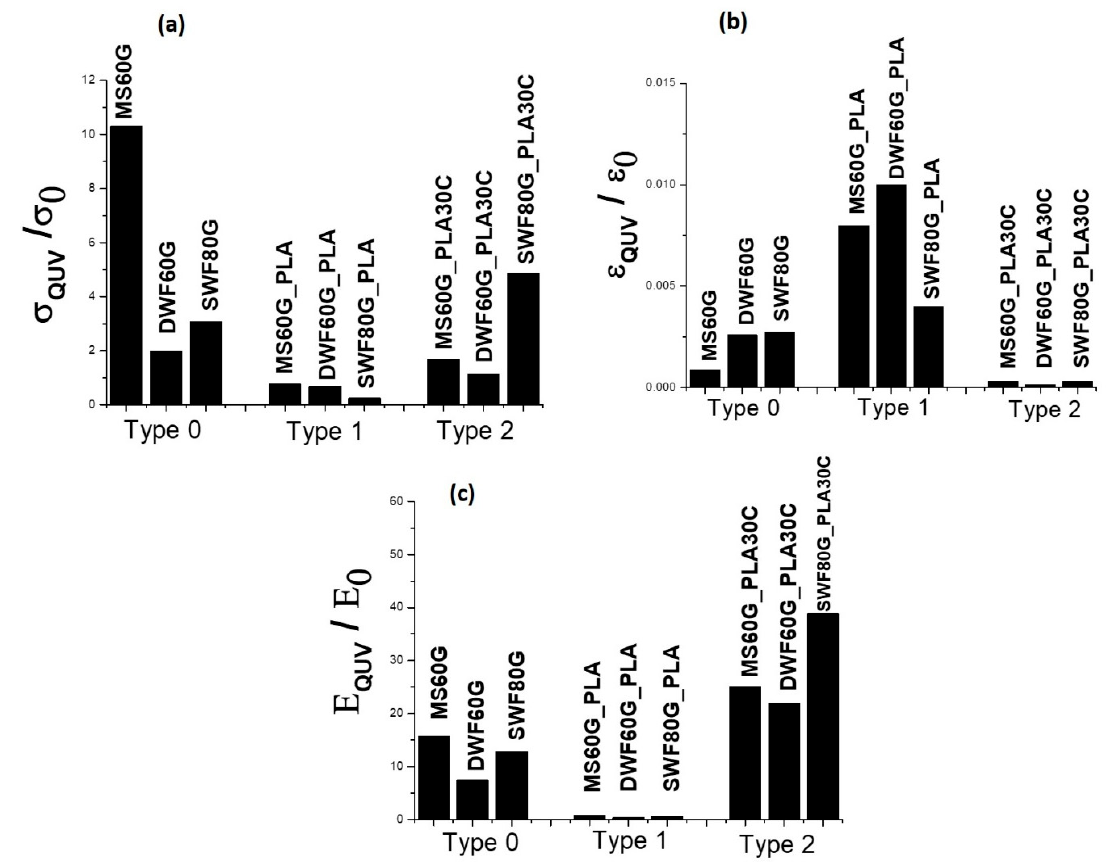
Figure 3. Ratios of tensile strength ( a ), deformation ( b ) and elastic modulus ( c ) of maize starch (MS)-based, durum waste flour (DWF)-based and soft waste flour (SWF)-based bio-films before and after QUV ageing.